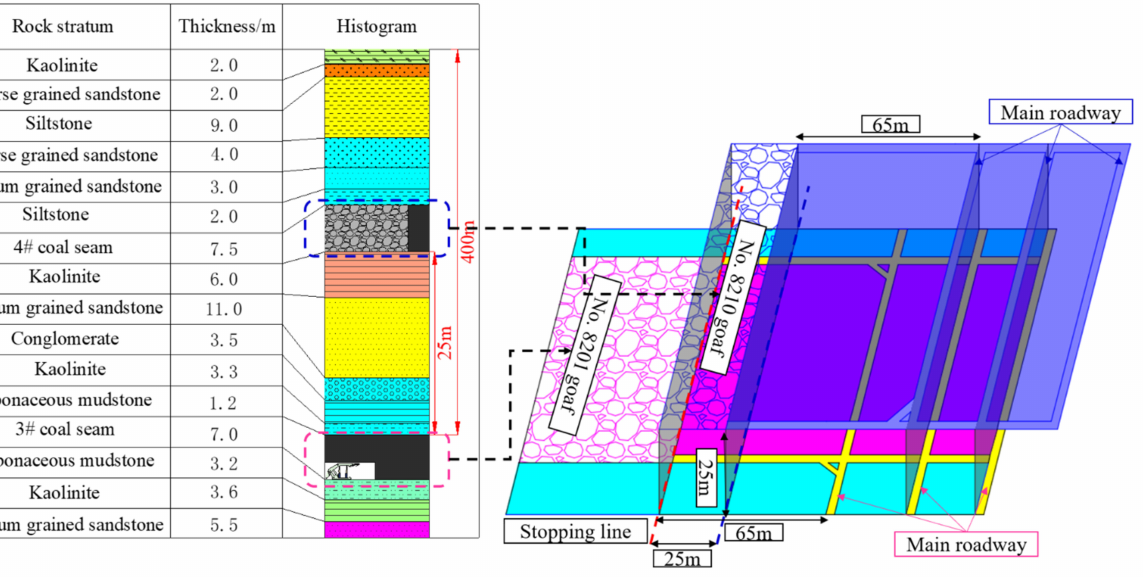
Figure 3. Geological histogram of panel and position relationship diagram of the upper and lower working